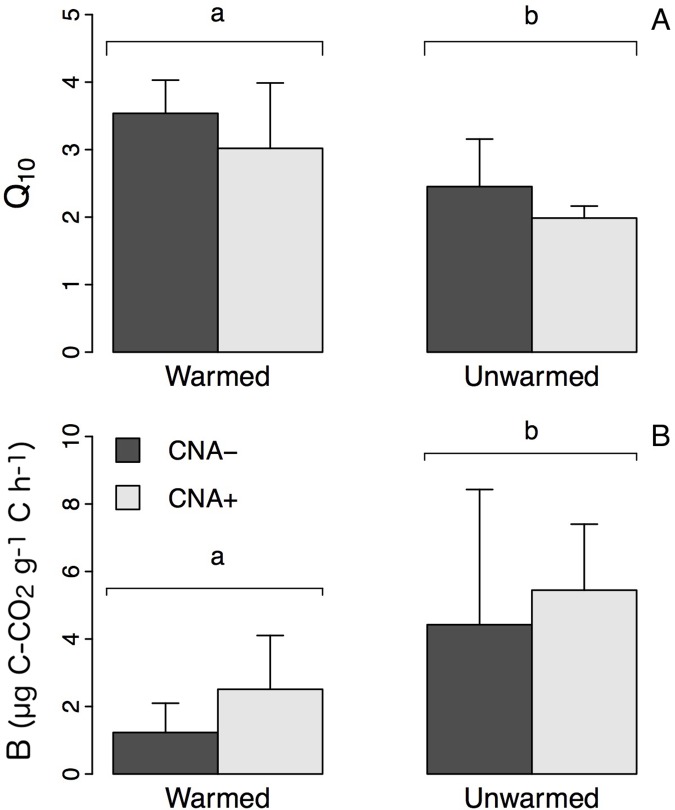
Impact of soil warming and CNA on the temperature sensitivity and the basal rate of forest floor respiration.(A) Mean (± SD) Q10 and (B) mean (± SD) B values in “warmed” and “unwarmed” experimental plots with no canopy N addition (CNA-) or with canopy N addition (CNA+). Different letters indicate a significant effect of soil warming on Q10 and B values (ANOVA with warming and CNA treatments as independent variables; P < 0.05).